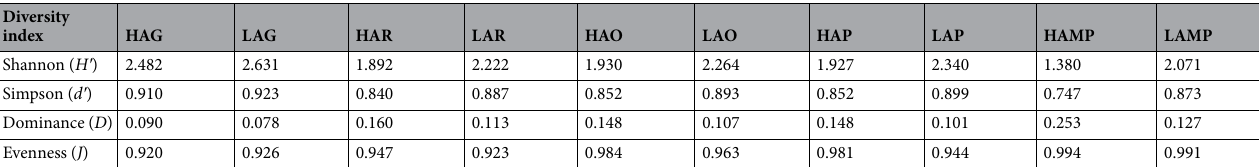
Table 5. Diversity of isolated bacterial strains from different study sites of Dachigam National Park, Kashmir.